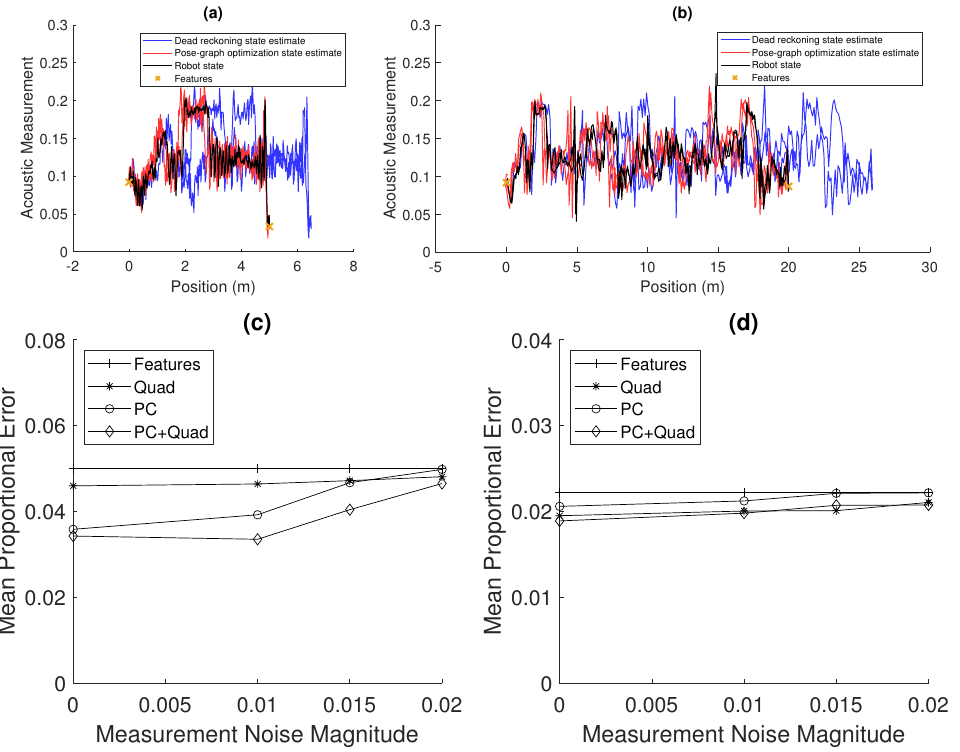
Figure 8. Results showing the robustness of the developed methods to noise in the measurement of spatially varying acoustic property: ( a , b ) example recorded acoustic signals over 5 m and 20 m with additive normally distributed noise with a standard deviation of 10 percent of the signal amplitude. ( c , d ) An analysis of the sensitivity of the estimation method to noise in the acoustic signal: for varying measurement noise magnitude (the variance of the normally distributed noise added to the signal measurement), a measure of the mean error was measured for both 5 m (with 0.06 motion noise) ( c ) and 20 m (with 0.02 motion noise) ( d ) pipes. The median is shown for each method. Slightly different parameters are used for the phase-correlation method compared to the results in Figure 7, reducing the threshold to which matches are compared, which allows matches to be found in the presence of